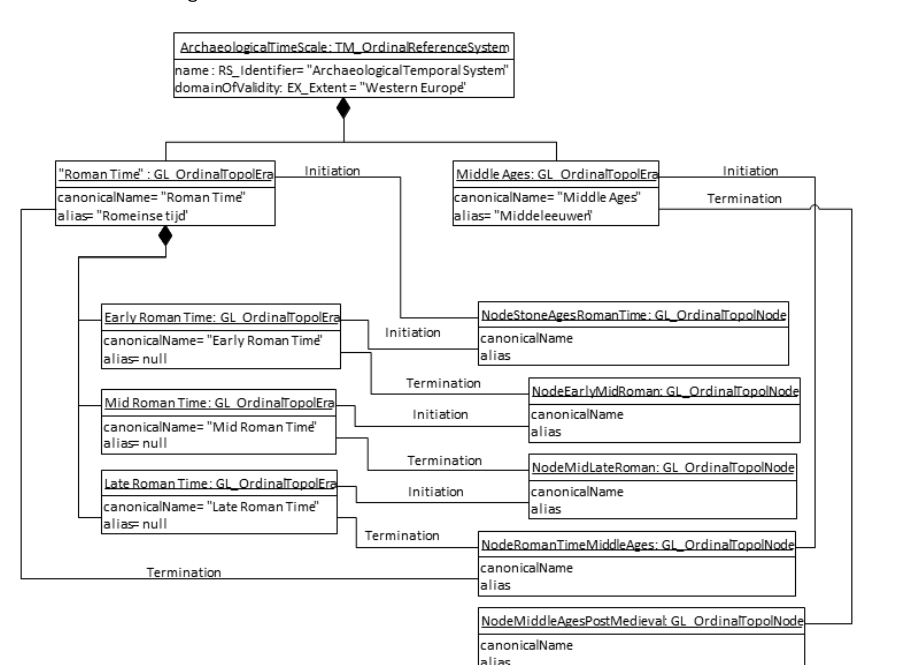
Figure 12 Archaeological time scale as temporal ordinal reference system according to the model of Michalak